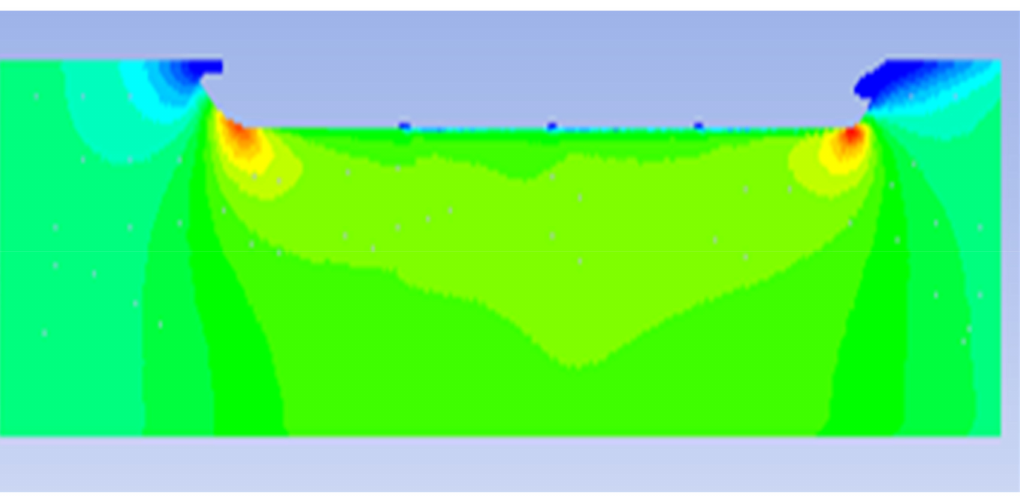
Figure 5. Distribution of dynamic pressure in the flow-field with air lubrication.